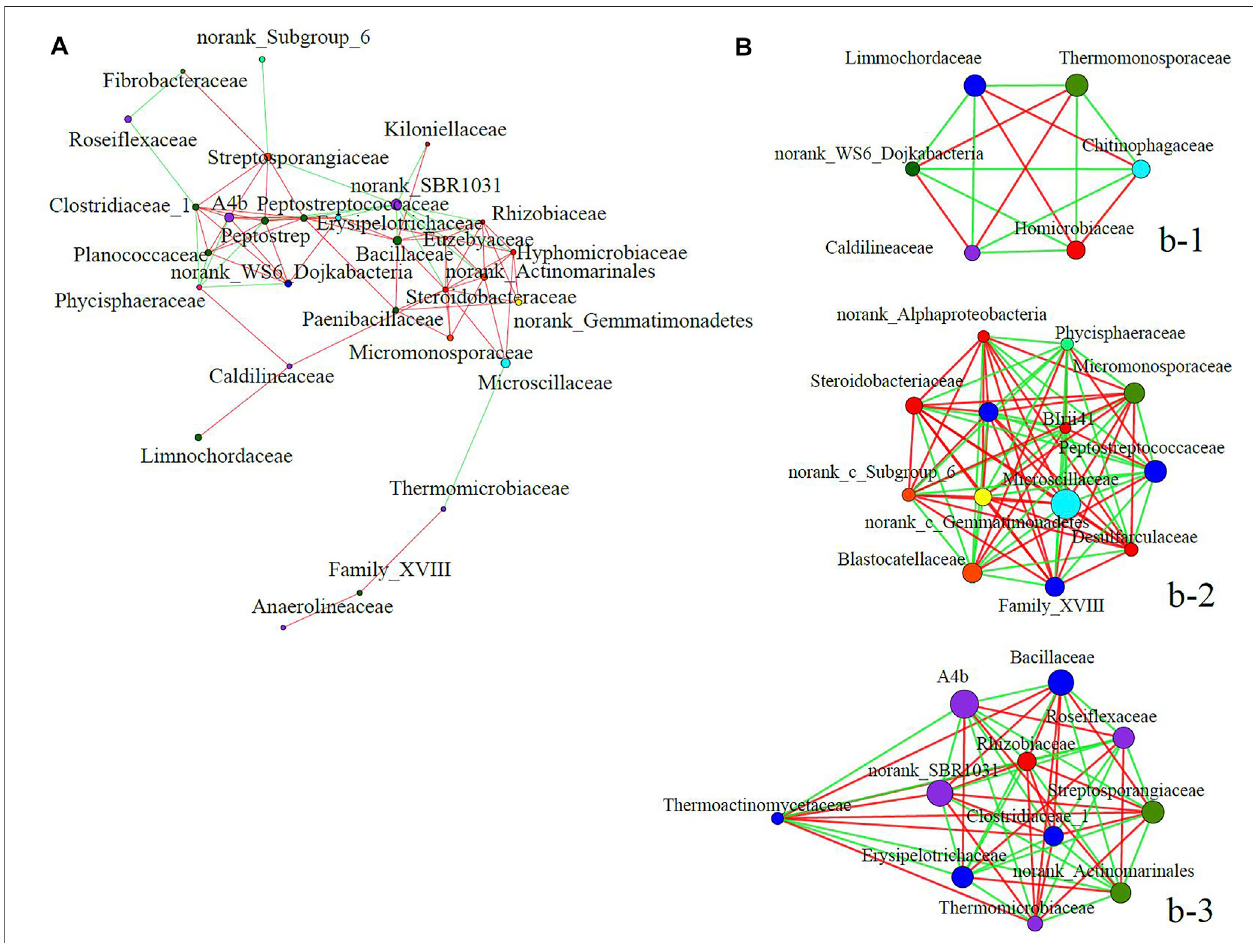
FIGURE 5 | Single factor correlation networks of bacterial community structure at the family level. (A) Network analysis excluding the cipro fl oxacin treatment; (B) network analysis of the cipro fl oxacin treatment. Spearman correlations were used to analyze the relationships between species, r s ≥ 0.5, p value < 0.05. The size of a node indicates the abundance of a species; the red lines show signi fi cant positive correlations and the green lines show the signi fi cant negative